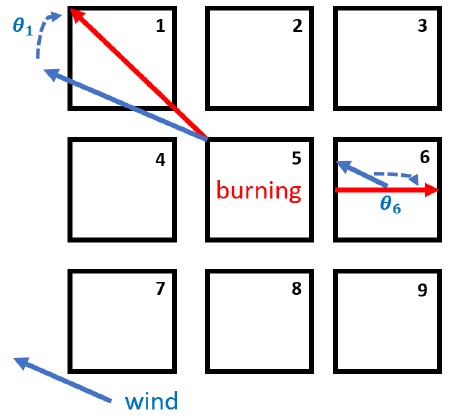
Figure 1. Wind effect in the CA modelling.